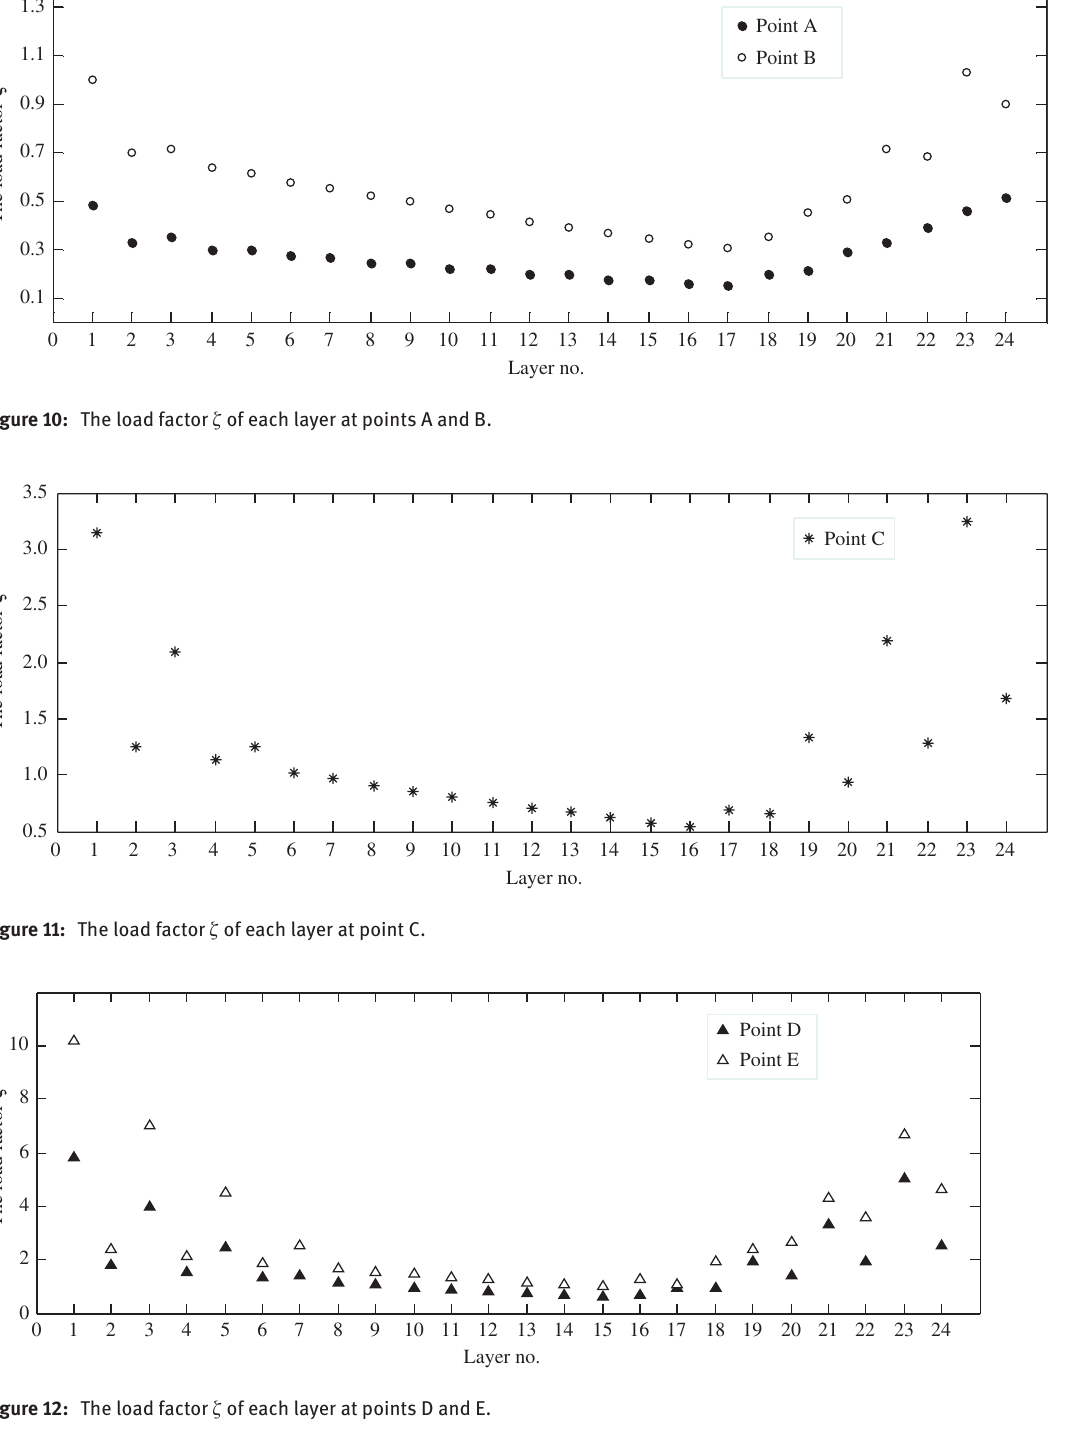
Figure 12: The load factor ζ of each layer at points D and